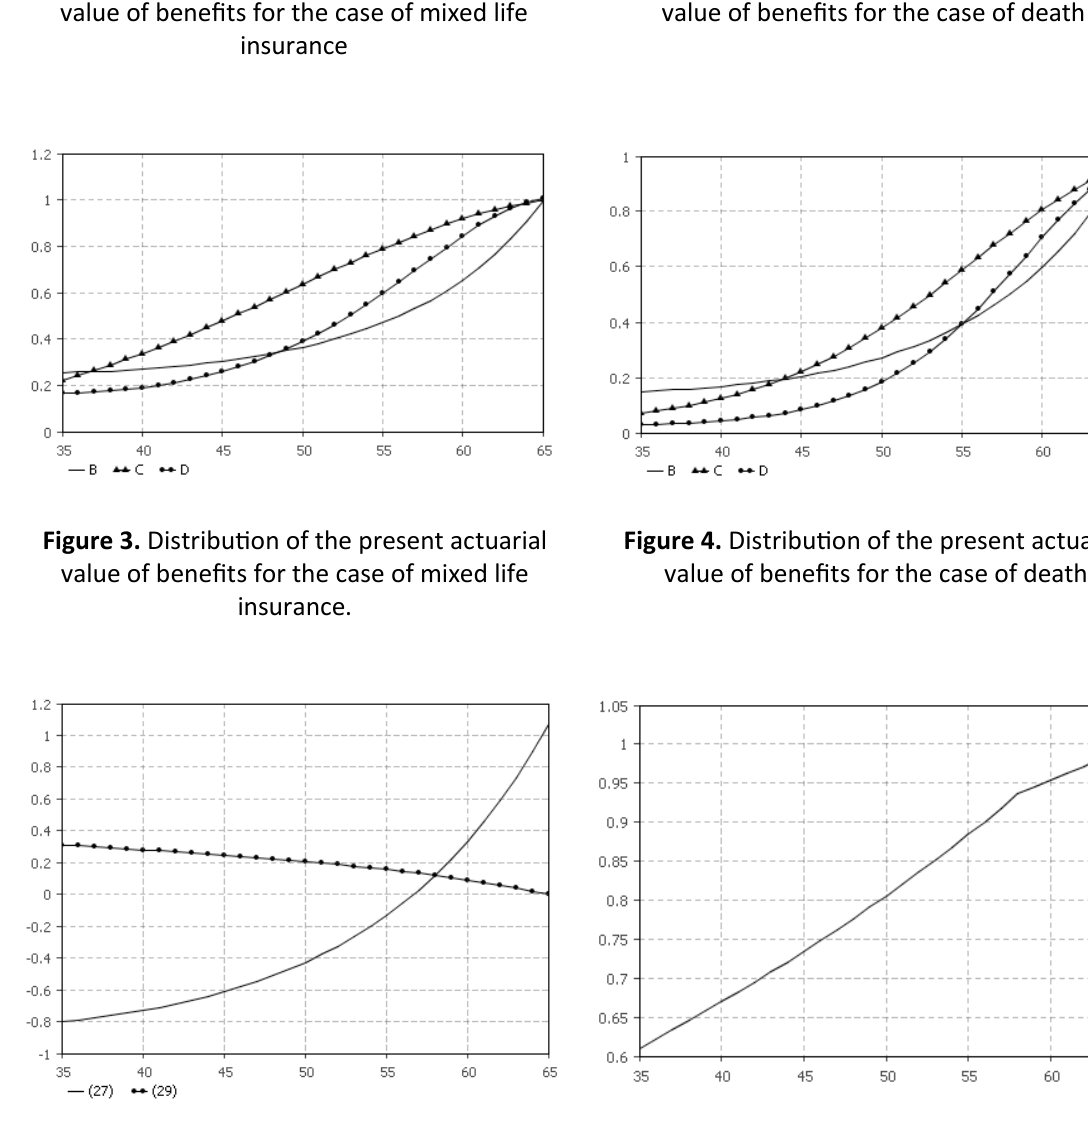
Figure 6. Distribution of the present actuarial value of benefits for the case of mixed life ( ) 0.01 i = insurance